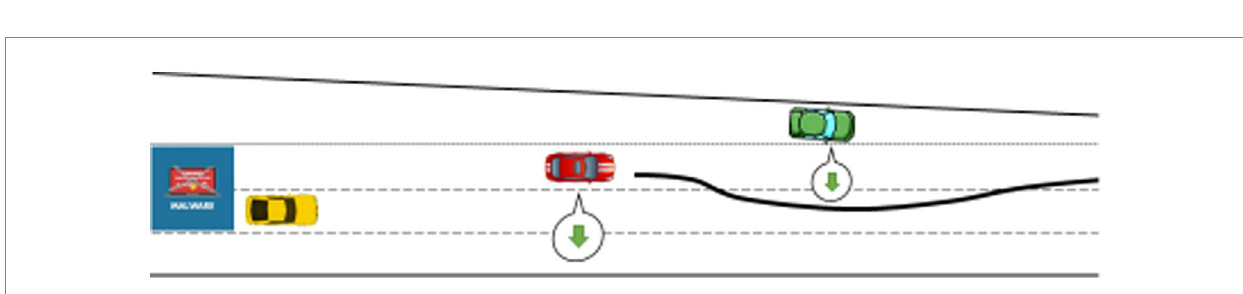
FIGURE 6 Explicit failure condition: the ego vehicle gives way to the green vehicle merging-in and then overtakes. A ransomware appears on the touchscreen when automated vehicle initiates the overtaking